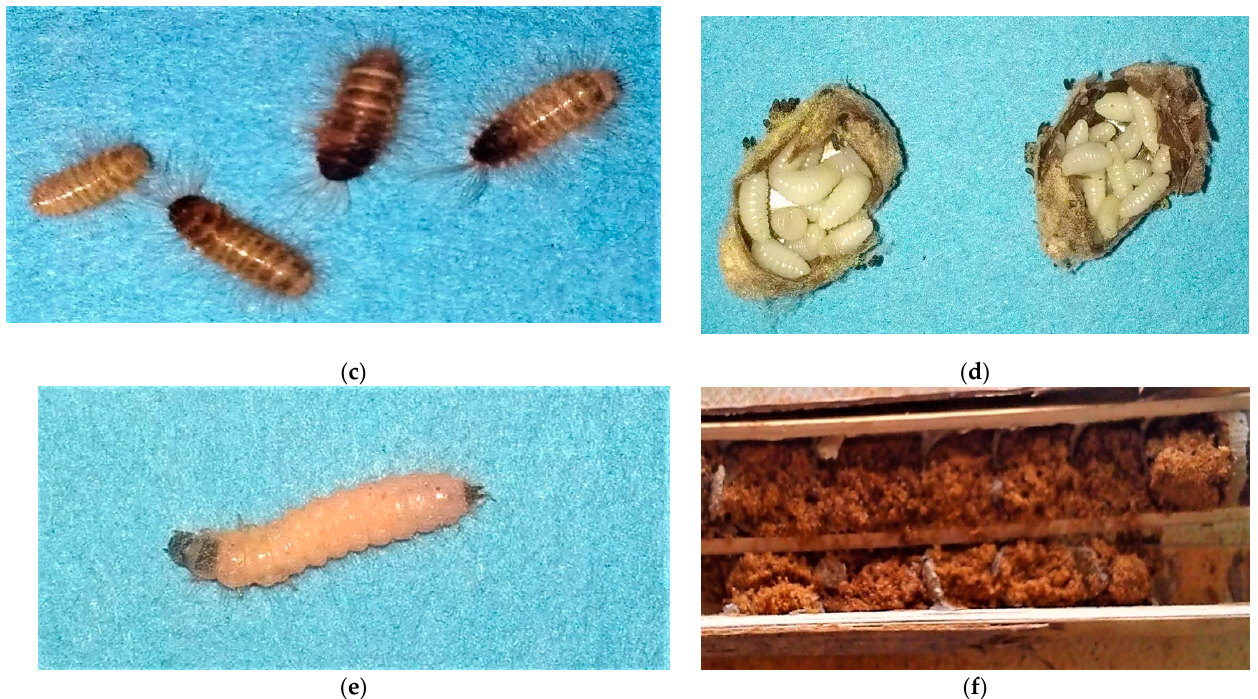
Figure 7. Common parasites of Osmia spp. bees’ nests: ( a )— Cacoxenus indagator young larvae; ( b )— C. indagator adults; ( c )— Monodontomerus obscurus overwintering prepupa inside cocoons; ( d )— Trichodes apiarius larvae; ( e )— Trogoderma glabrum; ( f )—destroyed cocoons invaded by Chaetodactylus osmiae mites.